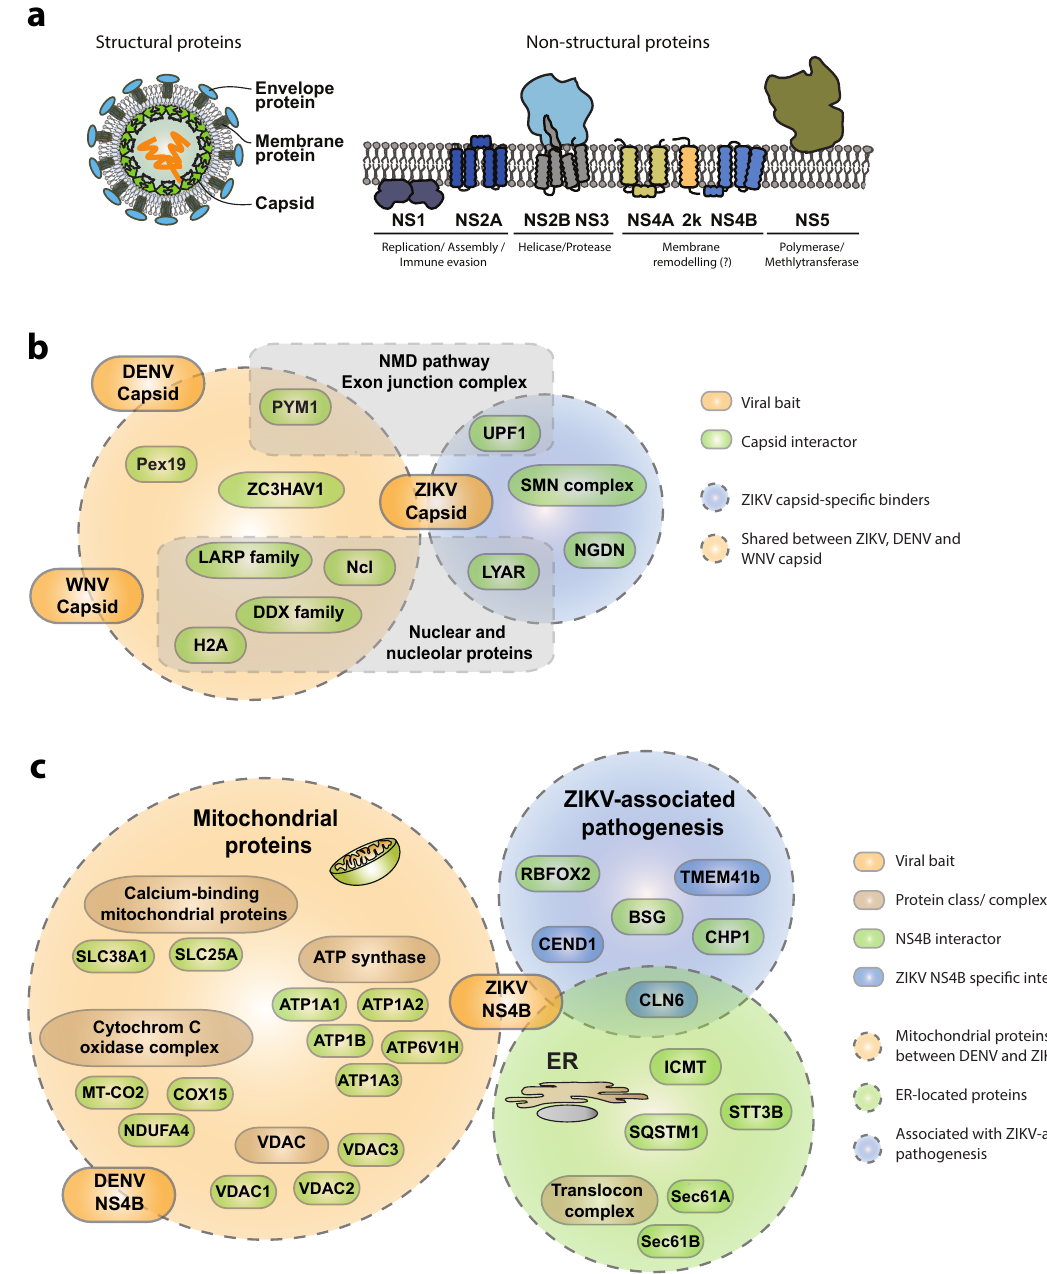
Figure 2. – Recently identified cellular interactors of flavivirus capsids and NS4Bs. ( a ) Schematic representation of flavivirus viral proteins and respective membrane topology. ( b ) Capsid interactors reported to bind exclusively to Zika virus (ZIKV)-C are surrounded by the light blue circle, while those within the orange circle were reported as shared interactors of ZIKV, West Nile virus (WNV) and Dengue (DENV)-C. The respective sub-cellular localization is indicated. ( c ) NS4B interactors reported to bind exclusively to ZIKV-NS4B are shown in blue, while those shared with DENV-NS4B are shown in green. Mitochondrial- and endoplasmic-reticulum-resident proteins are surrounded by green and orange circles, respectively. Proteins with functions associated to ZIKV-related pathologies are surrounded by the blue circle. All gene names and corresponding full protein names are listed in Table